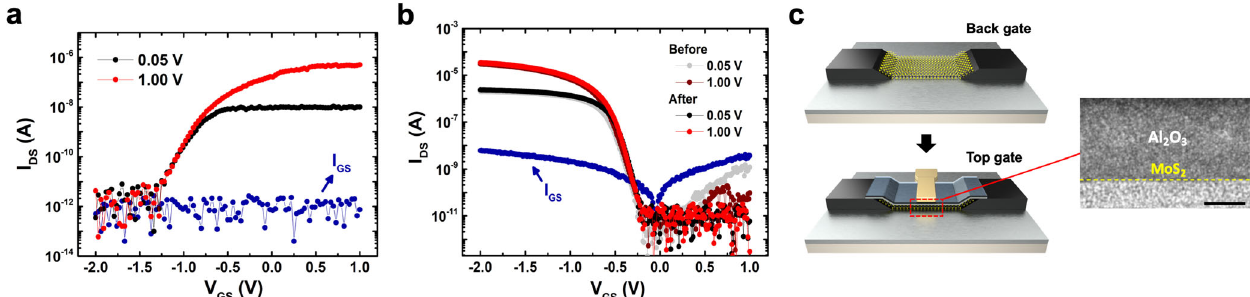
Fig. 4 Electrical characteristics of top-gated MoS 2 FET on upper-tier and lower-tier Si FinFET. Measured transfer characteristics of a a top- gate MoS 2 FET on intermediate SiO 2 layer and b a Si FinFET on Si/SiO 2 ( V DS = 0.05 V and 1.00 V). For the Si FinFET, the measurement was conducted before and after the MoS 2 FET fabrication. In a and b , the gate current ( I GS ) was measured to acquire the level of the leakage current in the fabricated transistors. c Schematic of the top-gated MoS 2 FET. The TEM image shows the cross-section of the top-gated MoS 2 FET. Scale bar, 10 nm.